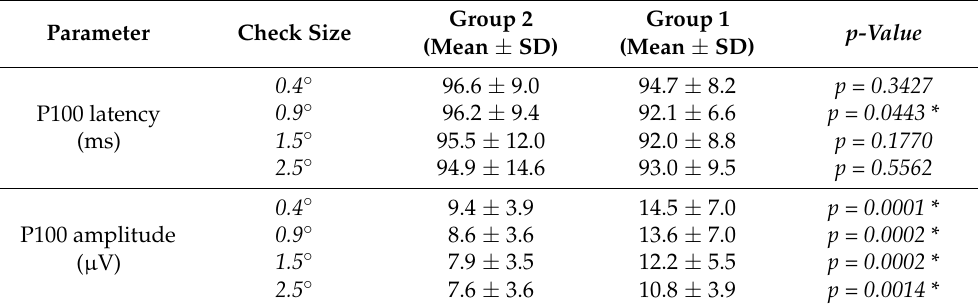
Table 5. A comparison of VEP components between GO patients with moderate-to-severe GO (Group 2) and patients with mild GO (Group 1).